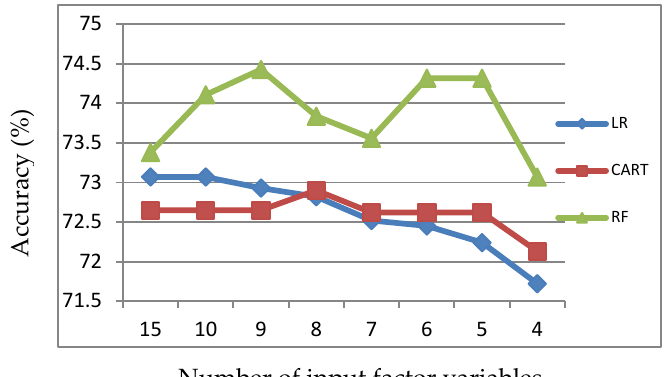
Figure 1. Accuracy of LR, CART and RF with input of significant variables identified by LR.